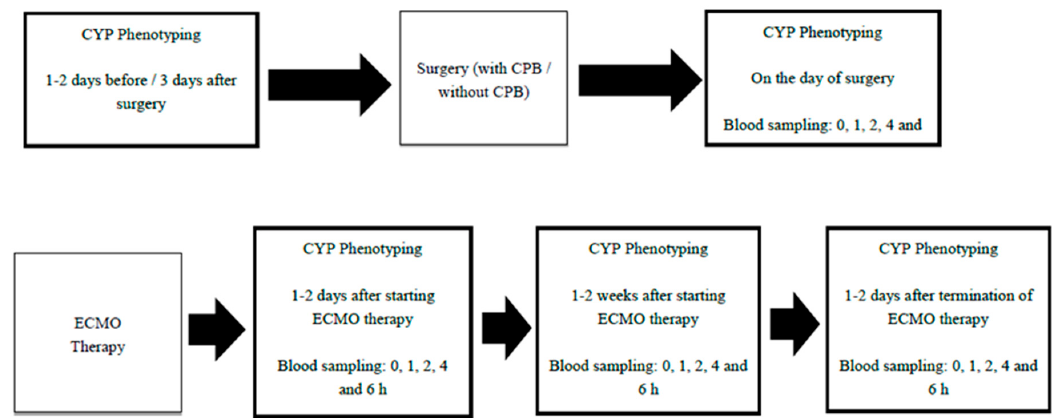
Figure 2. CYP phenotyping schedule for patients on ECMO and cardiac surgery with CPB